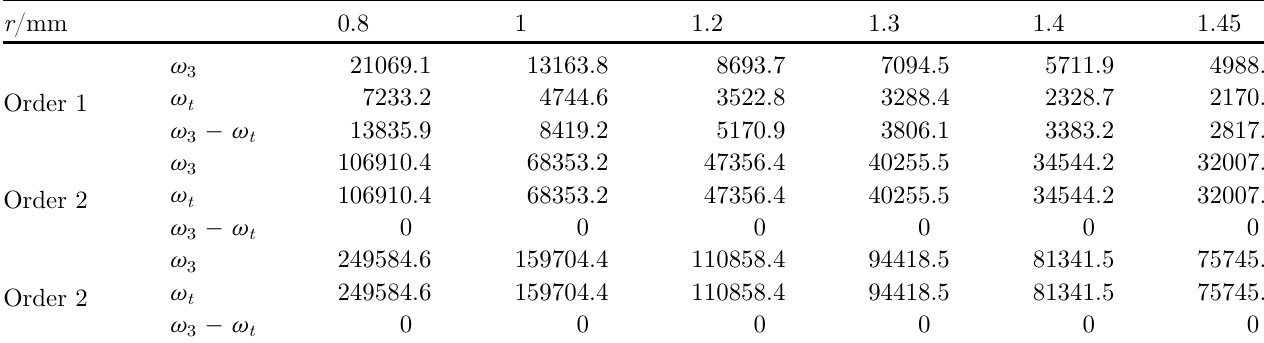
Table 6. Changes of natural frequency with r with and without friction force (rad/s).